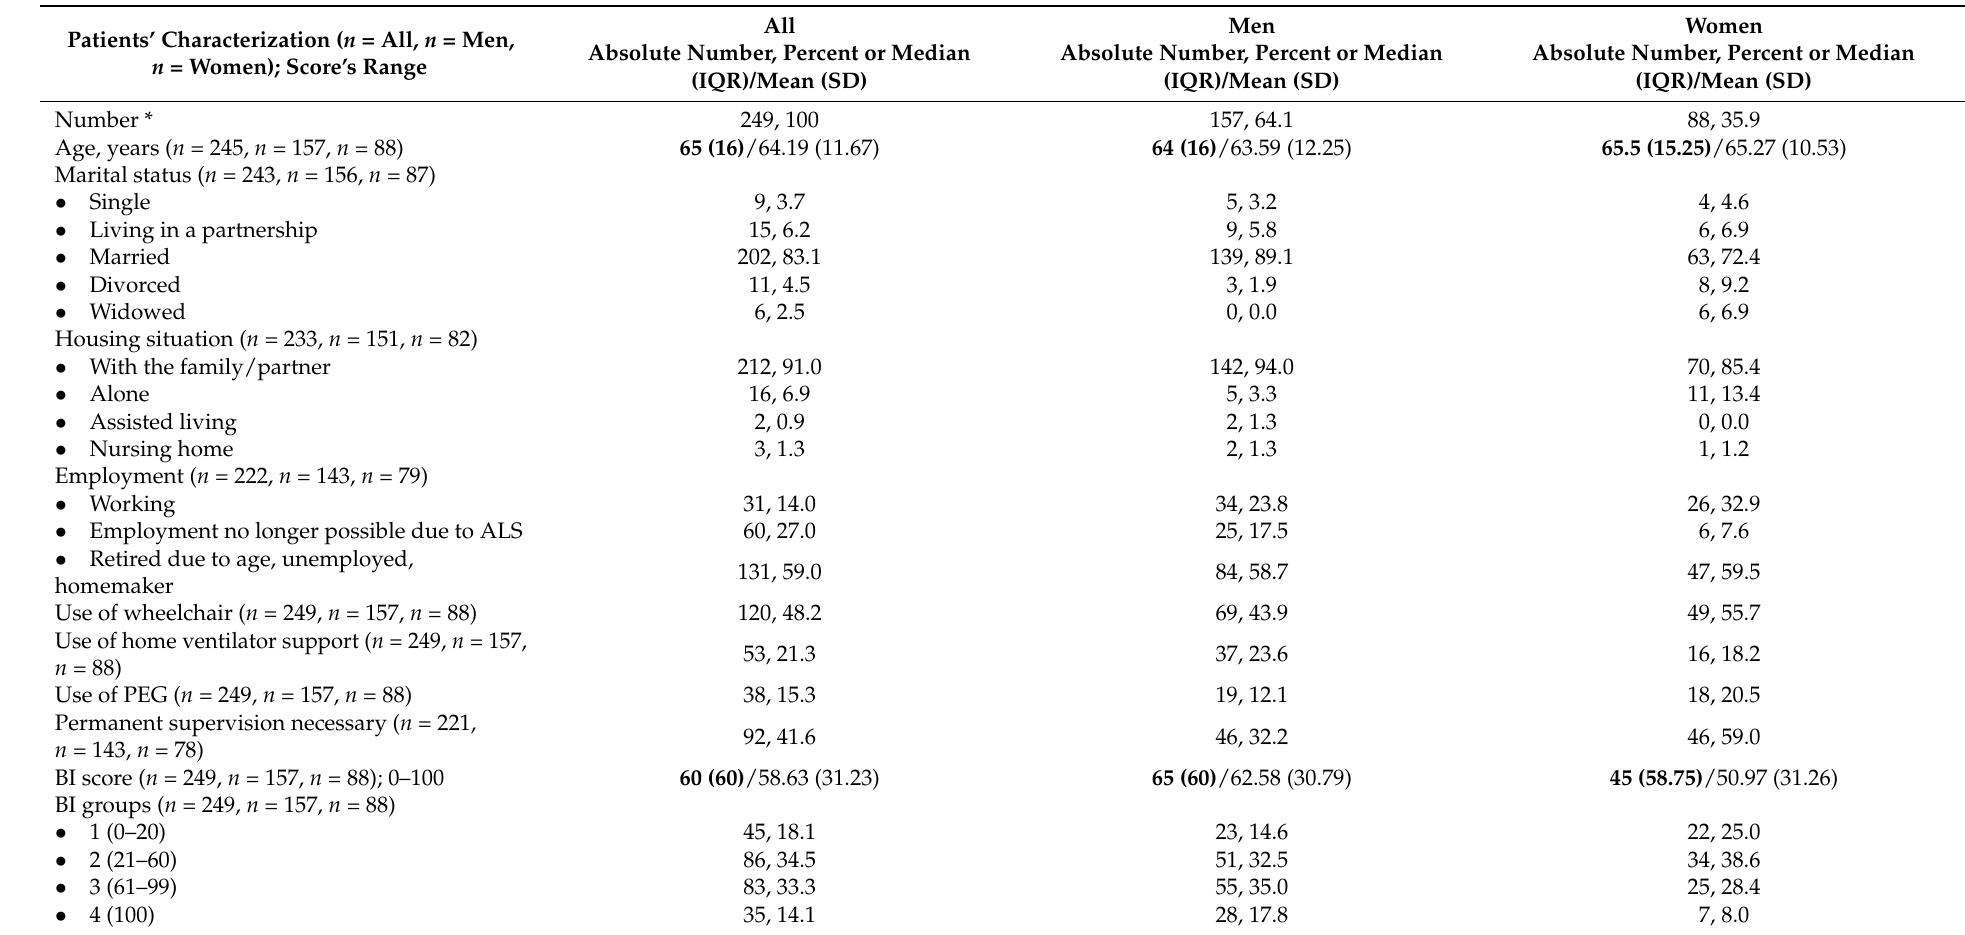
Table 1. Patients’ characterization. This table shows the patients’ characteristics, their functional status (BI, ALSFRS-R, BI groups) and their disease stages (King’s Stages). Due to rounding, the percentage might not add up to 100 exactly. * = Since some data (e.g., the sex of four patients) was unknown, not all numbers add up in total and result in different n . Abbreviations: n = number; IQR = interquartile range; SD = standard deviation; ALS = Amyotrophic Lateral Sclerosis; PEG = percutaneous endoscopic gastrostomy; BI = Barthel Index; ALSFRS-R = Revised Amyotrophic Lateral Sclerosis Functional Rating Scale. Median and IQR are presented in